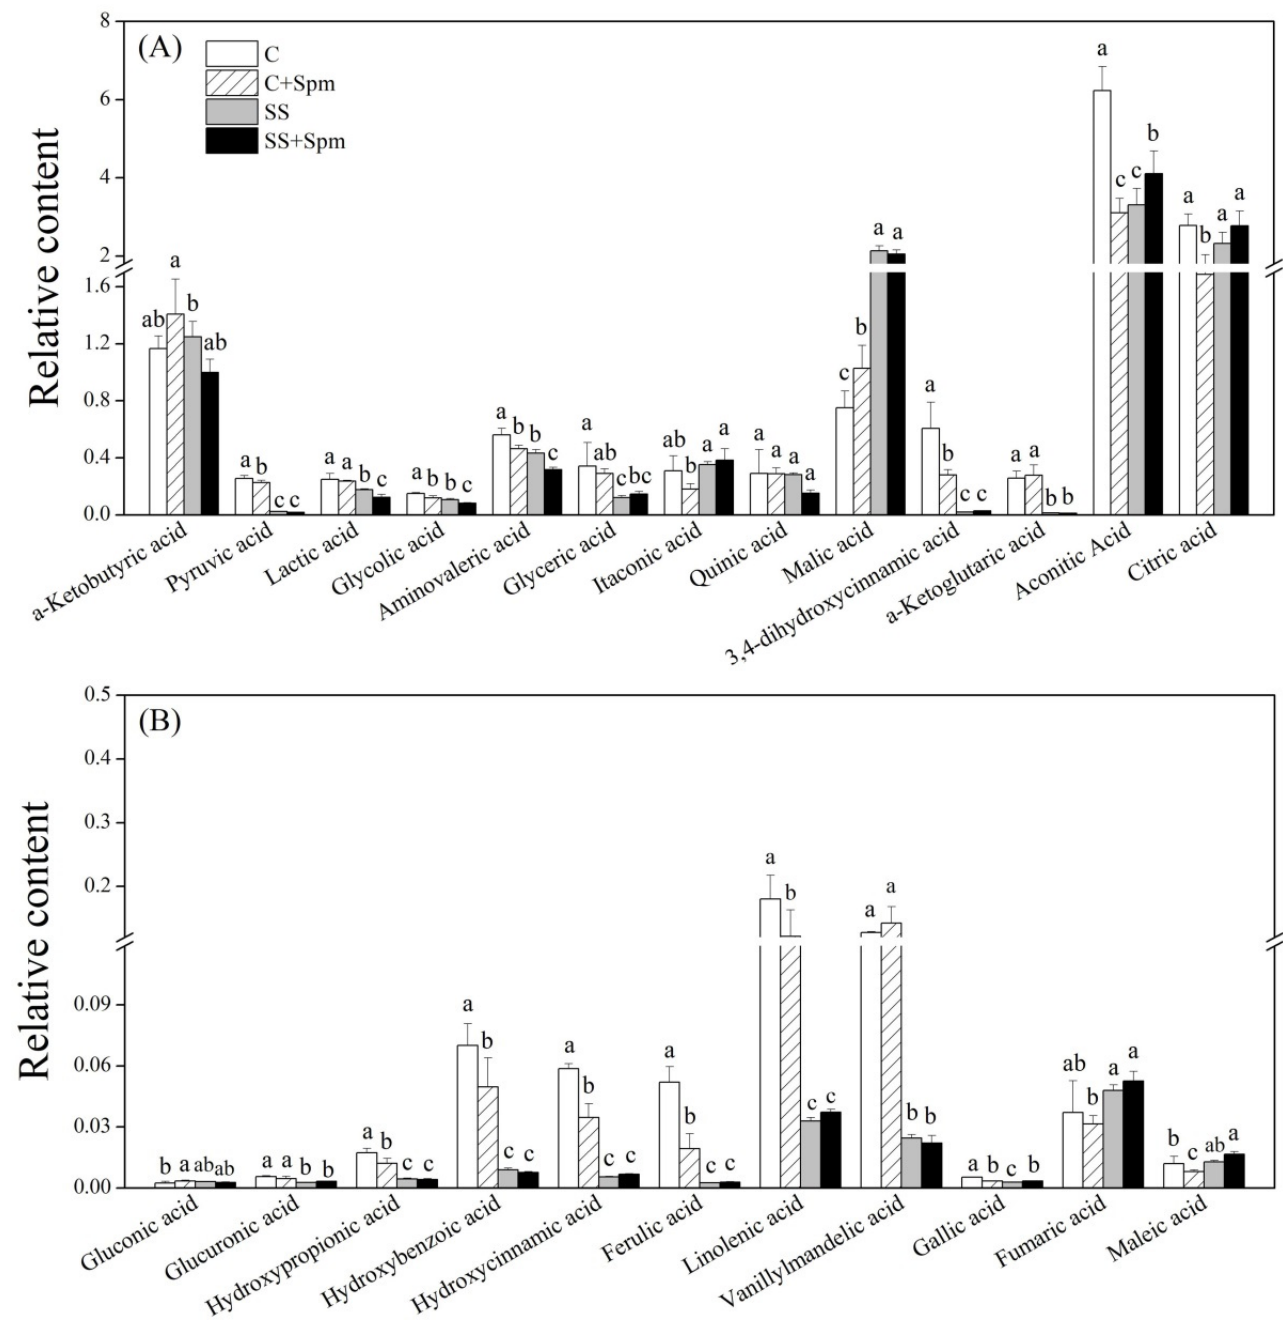
Figure 8. Effects of exogenous application of spermine (Spm) on ( A ) and ( B ) organic acids under normal conditions and salt stress. Vertical bars indicate ±SE of mean (n = 4). Different letters above columns indicate significant differences based on LSD ( p < 0.05). C, control; C + Spm, control + Spm; SS, salt stress; SS + Spm, salt stress + Spm.